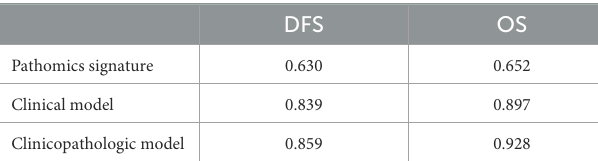
TABLE 2 The C-index of the different models on the validation